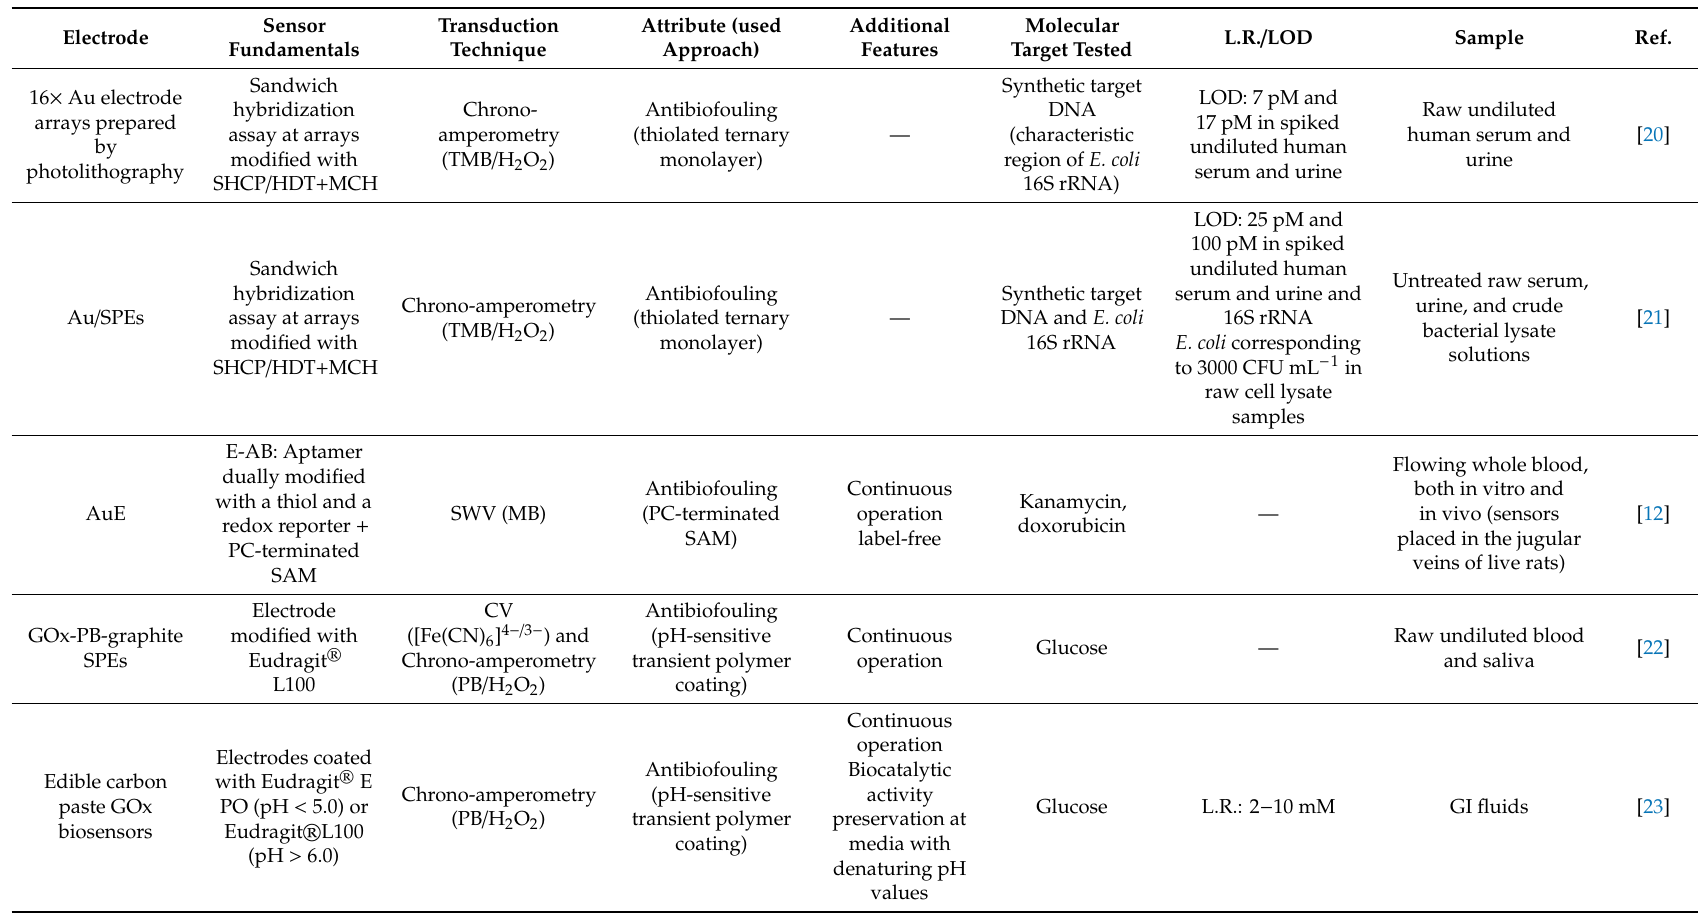
Table 1. Representative electrochemical (bio)sensors exhibiting remarkable sensing attributes beyond sensitivity and